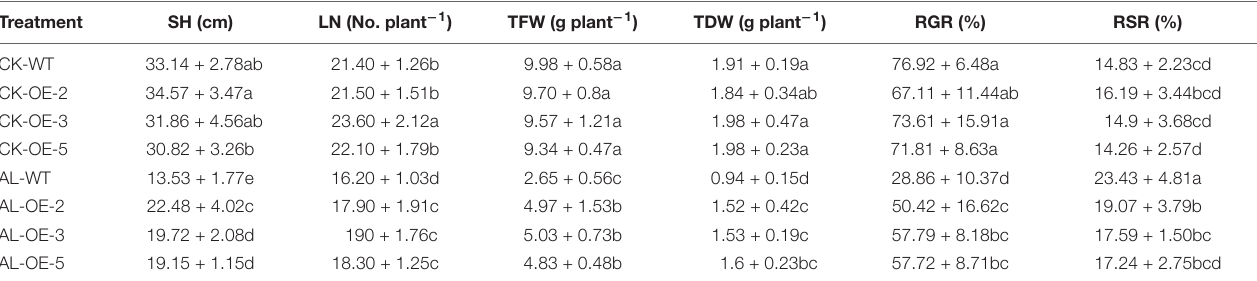
TABLE 1 | Stem height (SH), leaf number (LN), total fresh weight (TFW), total dry weight (TDW), relative growth rate (RGR), and root stem ratio (RSR) of MdTyDc-overexpressing apple plants after 15 days under control and alkaline conditions. Treatment